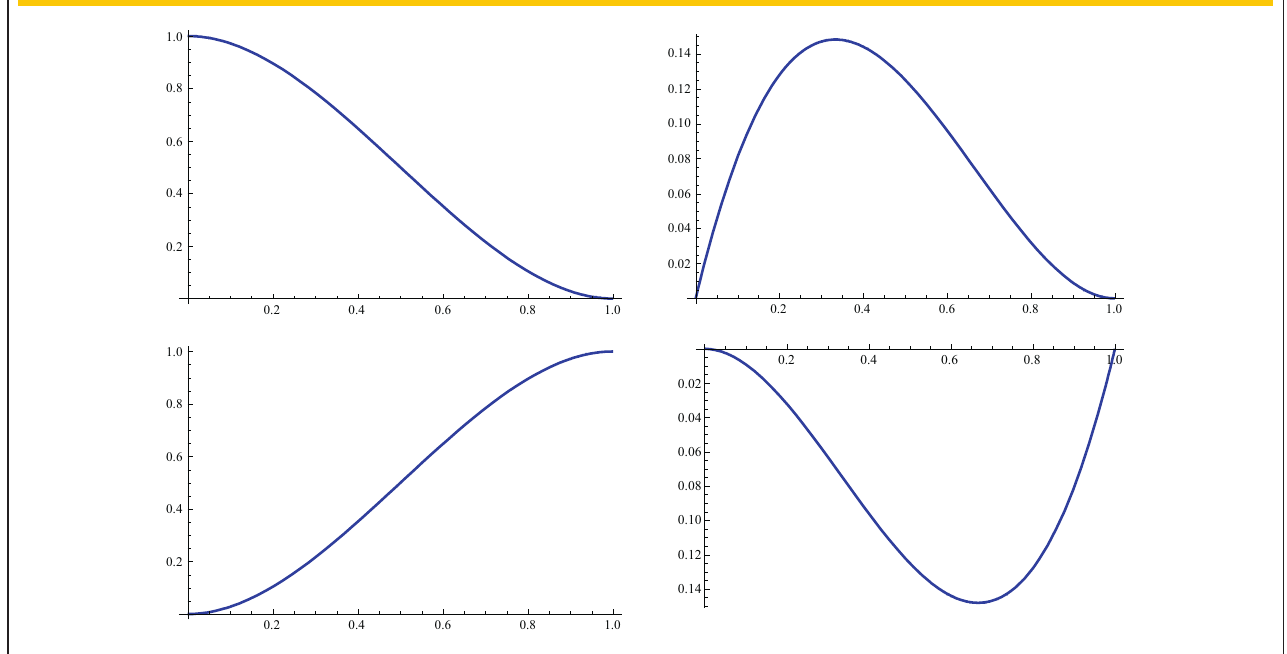
Figure 6 – Cubic Hermite shape functions of an